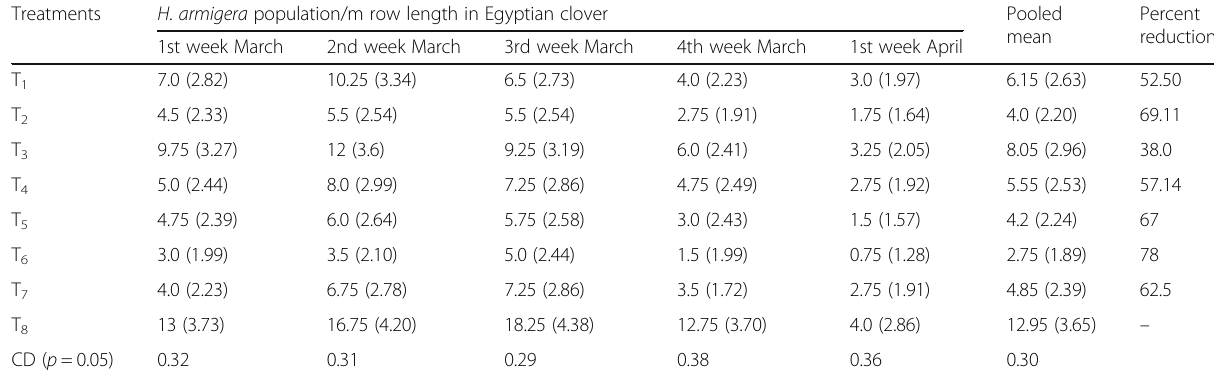
Table 2 Larval population of H . armigera in different treatment combinations in berseem during flowering stage Treatments